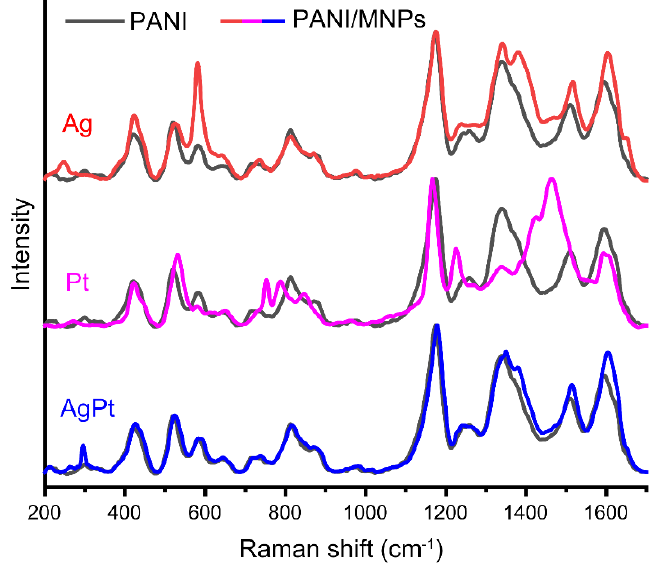
Figure 3. Raman spectra for pure PANI (black lines) and PANI/MNP (Ag, Pt, AgPt) composites (red, magenta and blue lines, respectively).